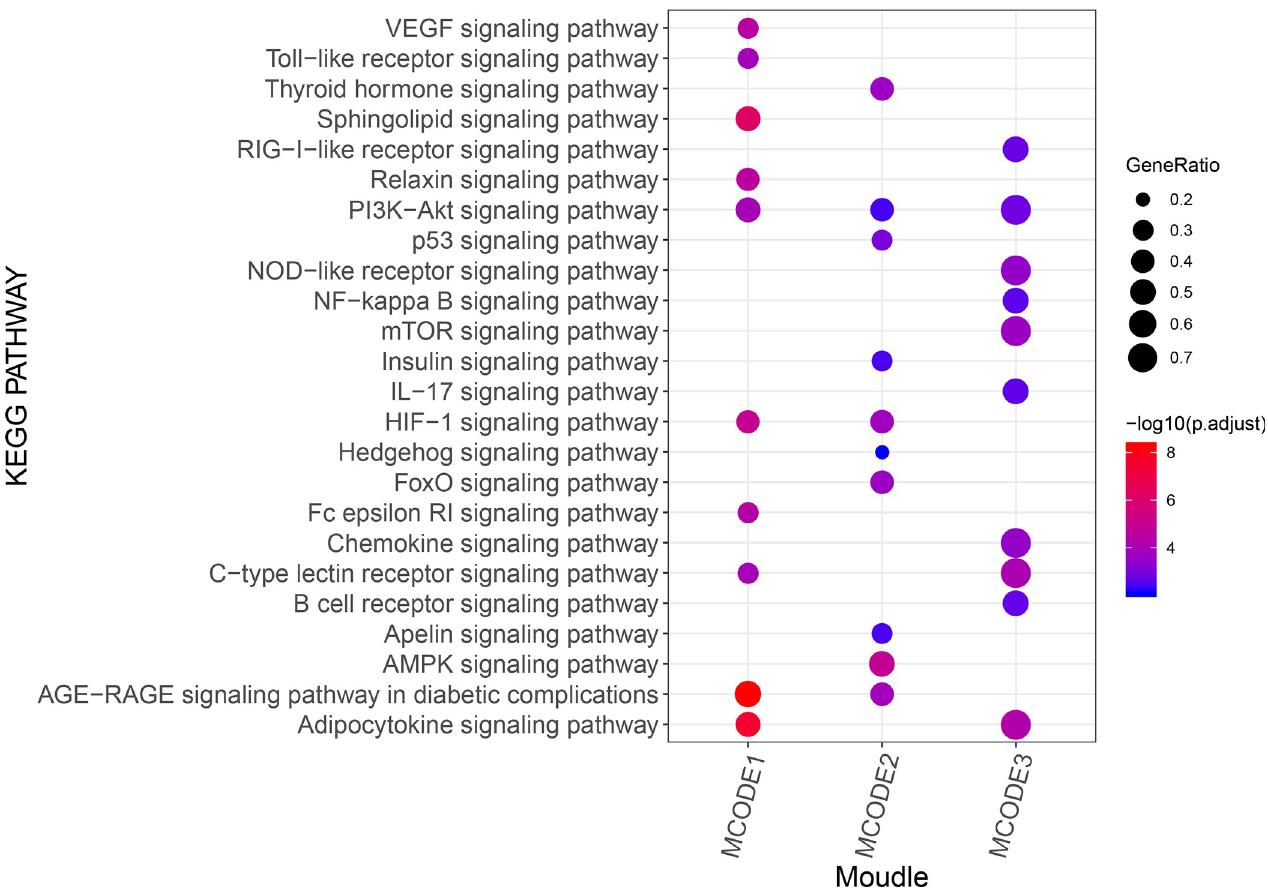
Fig 3. The top 10 signaling pathways in the PPI network. The size of the dot represents the proportion of the number of enriched genes to the total number of genes, with larger dots representing larger proportions; the redder the dot color, the more significant the p value.